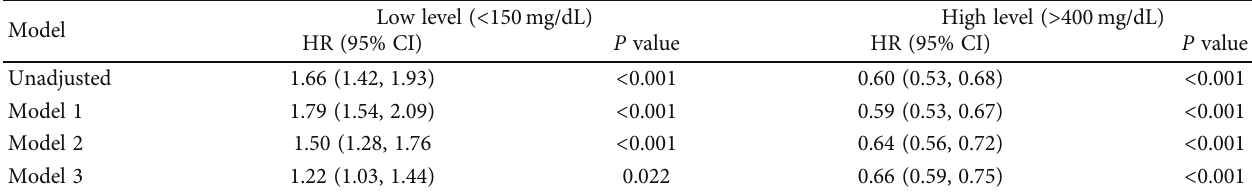
Table 5: Aggregation of Cox regression model.